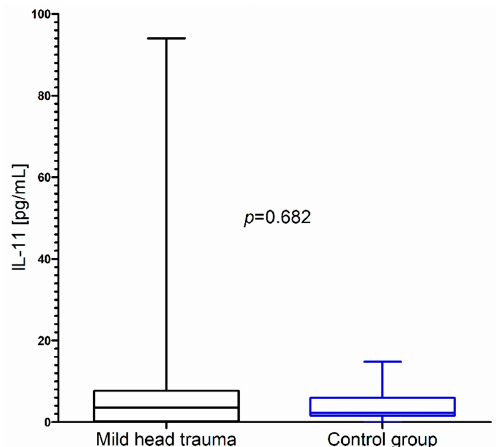
Figure 3. IL-11 concentration in the total group of children with mild head trauma compared to the control group. Brain Sci. 2020 , 10 , x FOR PEER REVIEW UCHL-1 levels in both children with mild head trauma and the control group were below the detection limit of the assay kit. Closer inspection showed that BDNF concentration was significantly higher in children with severe concussion with LOC than in the control group (Figure 4). We did not observe statistical differences in BDNF concentration between children with mild concussion without LOC and the control group ( p = 0.682).